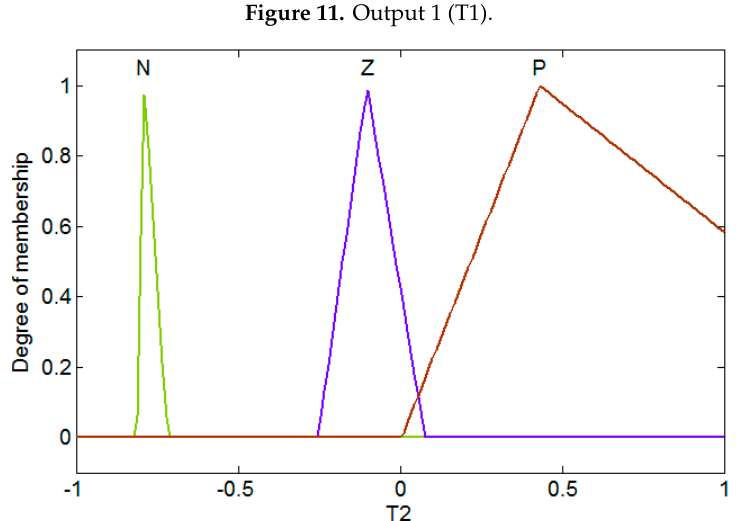
Algorithms 2019 , 12 FOR PEER REVIEW 15